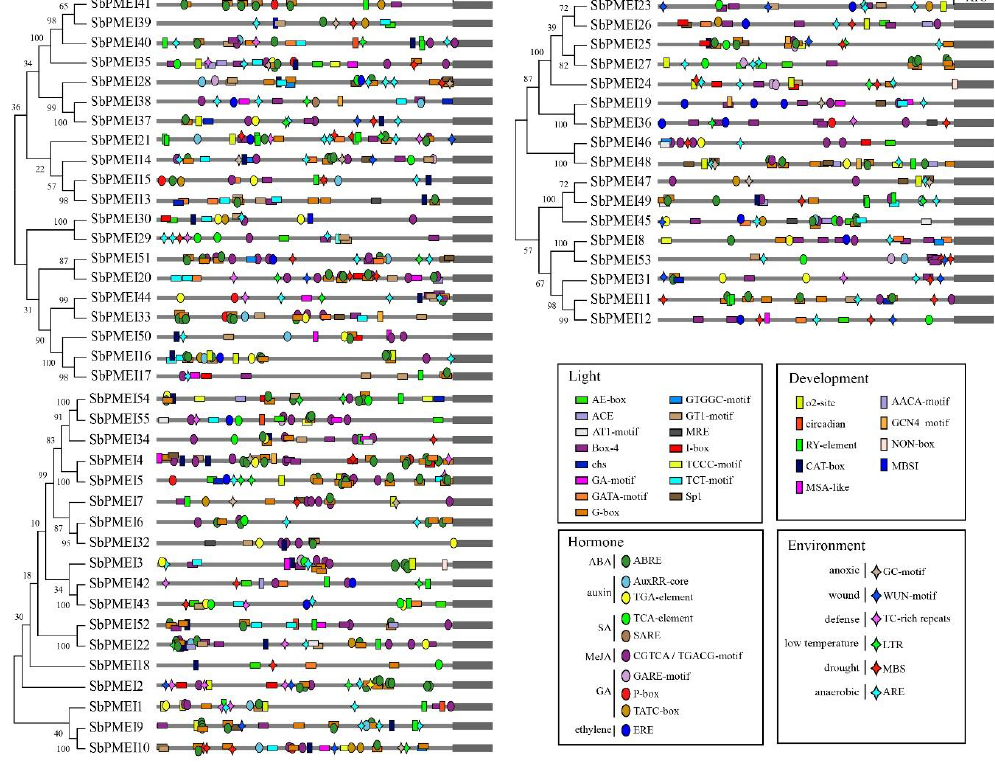
Figure 6. Cis -acting elements in the 1.5 kb promoter region of each PMEI gene of each subfamily in sorghum. 1.5 kb region before translation start codon (ATG) of each SbPMEI gene was analyzed by plant PlantCARE, and four major types of cis -acting elements were drawn above accordingly. The NJ phylogenetic tree was made with the proteins from the same subfamily.